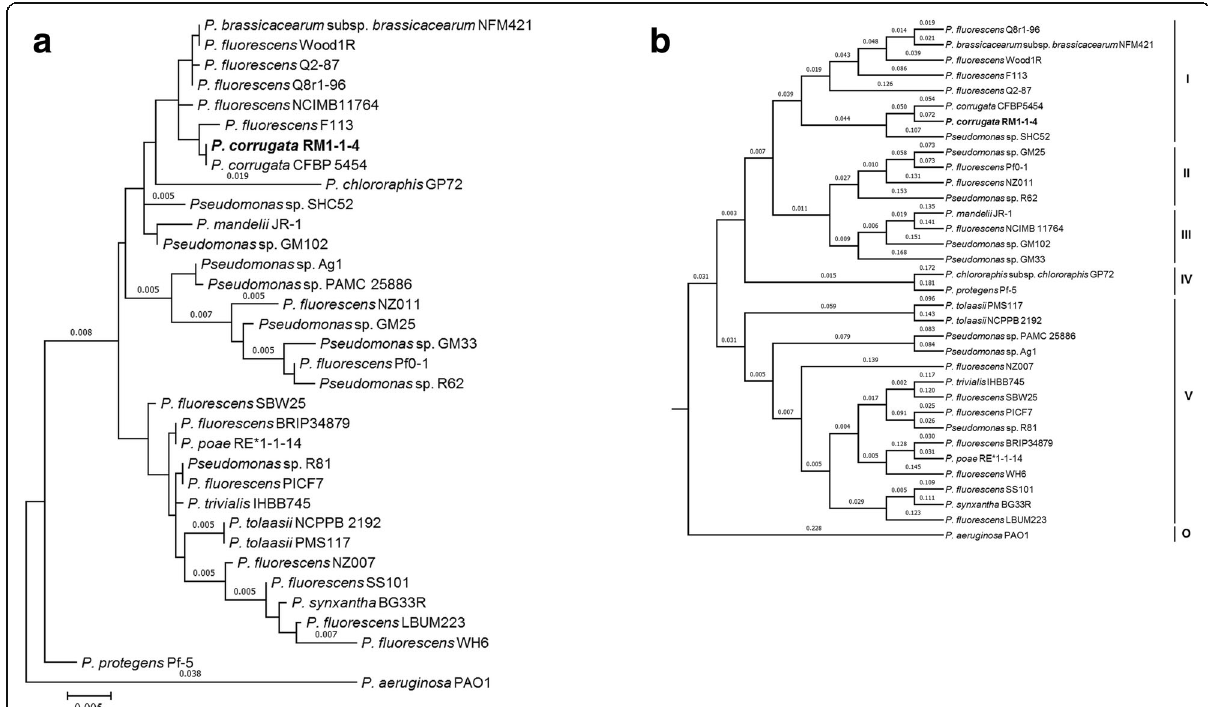
Fig. 2 Phylogenetic tree showing the position of P. corrugata RM1-1-14 in relationships among other strains of Pseudomonas spp. including P. aeruginosa PAO1 as outgroup. a The tree is based on 16S rRNA gene alignments and was conducted in MEGA6 [3]. Initial tree for the heuristic search were obtained automatically by applying Neighbor-Join and BioNJ algorithms to a matrix of pairwise distances estimated using the Maximum Composite Likelihood approach, and then selecting the topology with superior log likelihood value. b The dendrogram based on protein sequences for representative strains belonging to the existing five subgroups (I-V) of the P. fluorescens complex including P. aeruginosa PAO1 as outgroup (O) and was created by using Composition Vector Approach